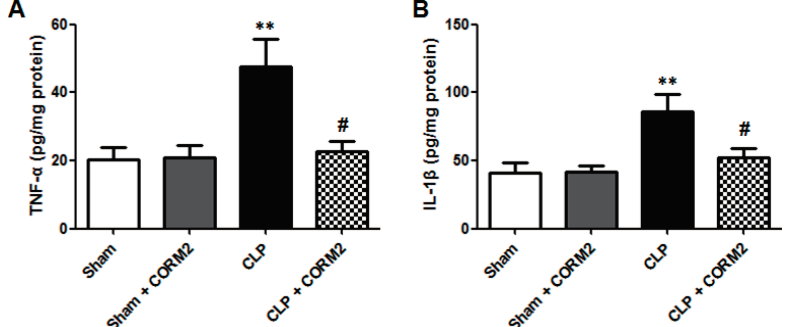
Figure 5. Carbon monoxide significantly decreased TNF- α and IL-1 β levels in renal tissues of septic rats. ( A ) The TNF- α and ( B ) IL-1 β levels in renal tissues were significantly increased at 12 h after CLP surgery, but CORM-2 treatment significantly decreased the TNF- α level in renal tissues. CORM-2 had no effect on TNF- α or IL-1 β levels in renal tissues to normal rats (Sham). Results are presented as mean ± SD, n = 6 rats per group. ** p < 0.01 vs. sham group and # p < 0.05 vs. CLP